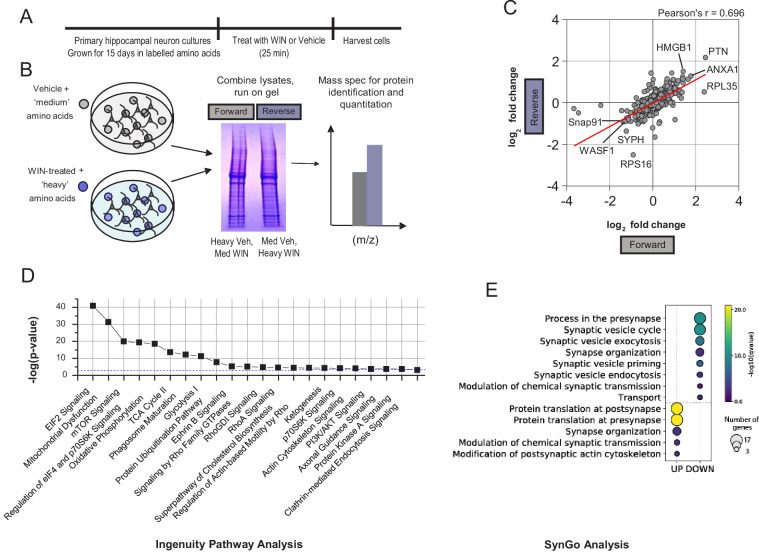
SILAC experiment design and additional analysis.(A) Experimental timeline for SILAC. Neurons were grown for 15 days in isotope-labeled amino acids, before being treated for 25 min with WIN and harvested. (B) Schematic of workflow to identify proteins. Cultures were lysed and combined to give ‘forward’ and ‘reverse’ replicates. Mass spectrometry was performed for identification and quantification of proteins altered by WIN treatment. (C) Scatterplot of all proteins identified in forward and reverse experiments by log2 fold change. Forward and reverse experiments are significantly correlated indicating good reproducibility (Pearson’s correlation coefficient = 0.696, p<0.05). Top regulated proteins are identified. HMGB1 = high mobility group box 1, PTN = pleiotropin, ANXA1 = annexin A1, RPL35 = ribosomal protein 35, SNAP91 = synaptosome associated protein 91. WASF1/WAVE1 = Wiskott Aldrich Syndrome Family 1,SYPH = synaptophysin, RPS36 = ribosomal protein 36. (D) Top 22 selected pathways identified by Ingenuity Pathway Analysis (IPA) ranked by -log10(p-value). Blue dashed line indicates p-value=0.001, all pathways have p<0.001. (E) SynGO term analysis identified significant upregulation of local synaptic translation pathways and downregulation of GO terms involved in presynaptic function, as indicated by log q-value. Size of circle represents number of genes identified per SynGO term.